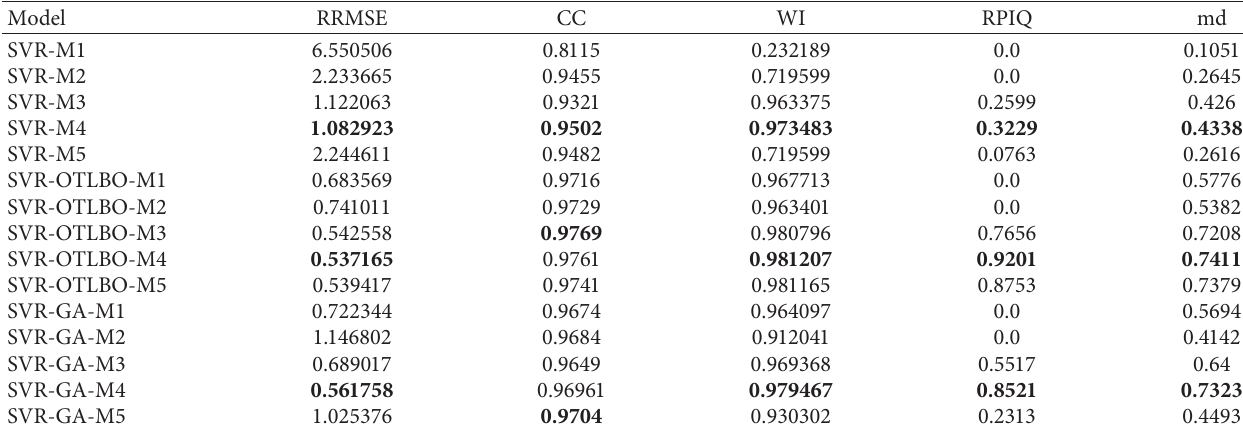
Table 4: The performance indices of the predictive models obtained in the testing